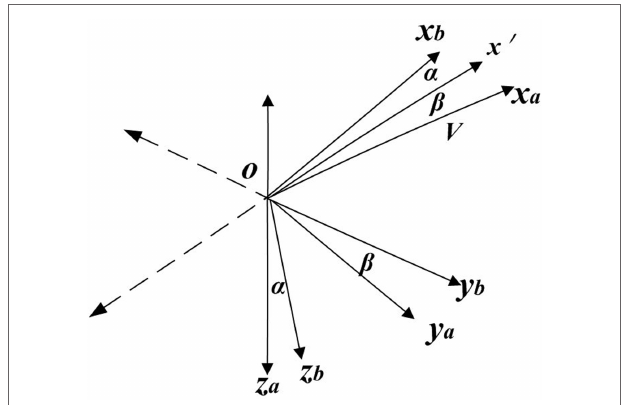
FIGURE 1 | Relationship between the speed coordinates ( Ox a y a z a ) and the vehicle coordinates ( Ox b y b z b